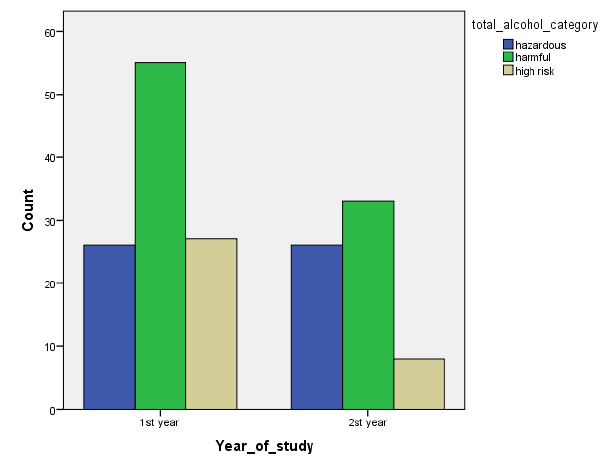
Figure 5. Frequency of tobacco and alcohol consumption depending on year of study (male).